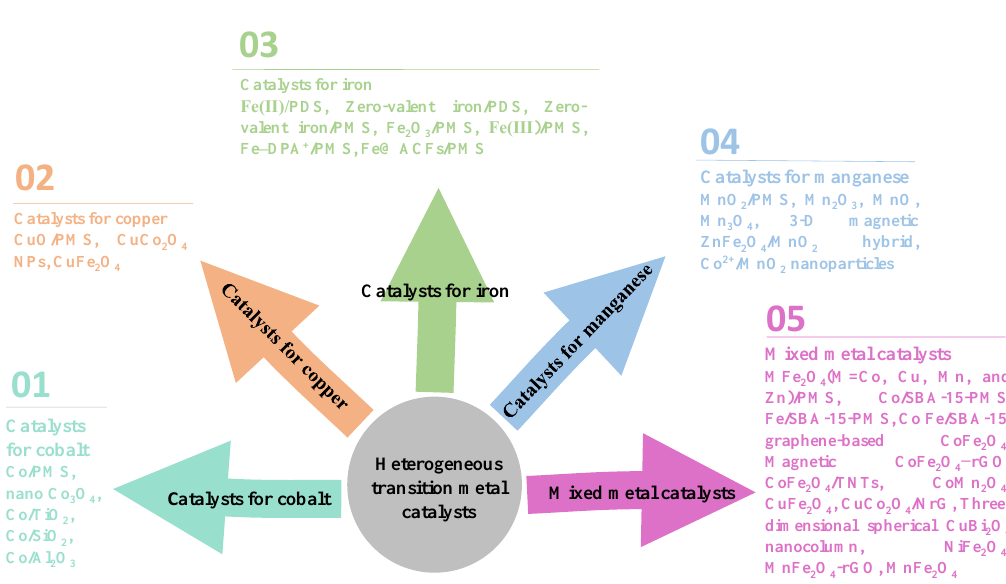
Figure 1. The species of heterogeneous transition metal catalysts.